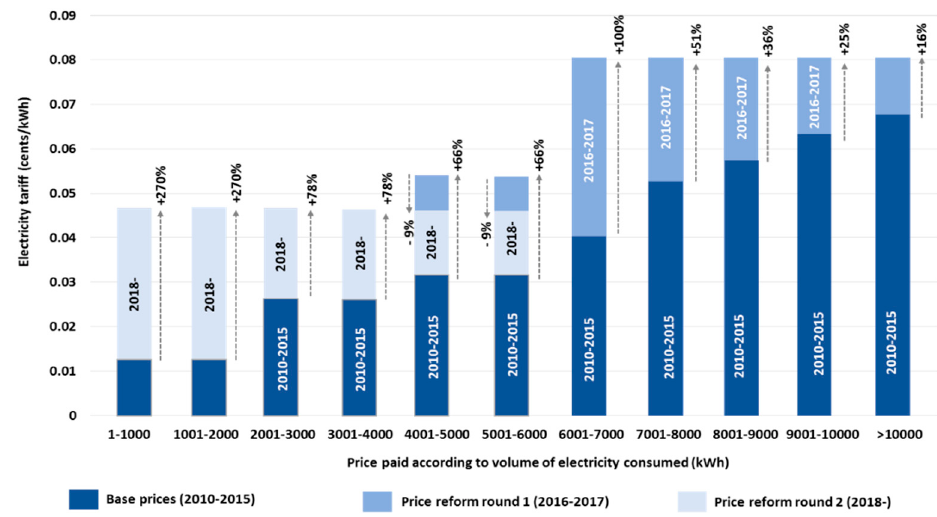
Figure 4. Saudi Arabia’s 2016 and 2018 electricity price reforms. Source: Authors based on ECRA [53].